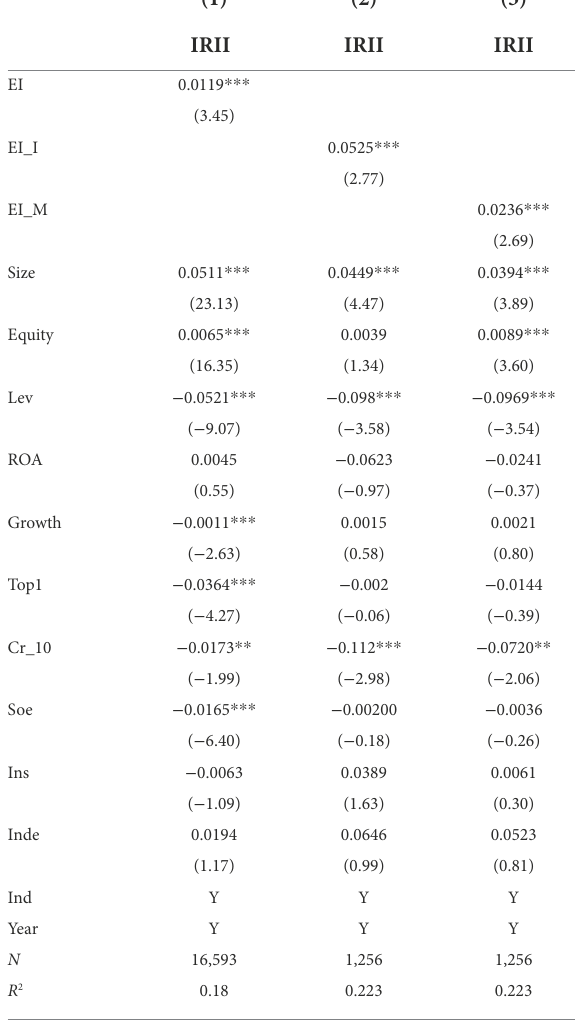
TABLE 5 Regression results of executive equity incentive plans (EEIPs) and investor relations